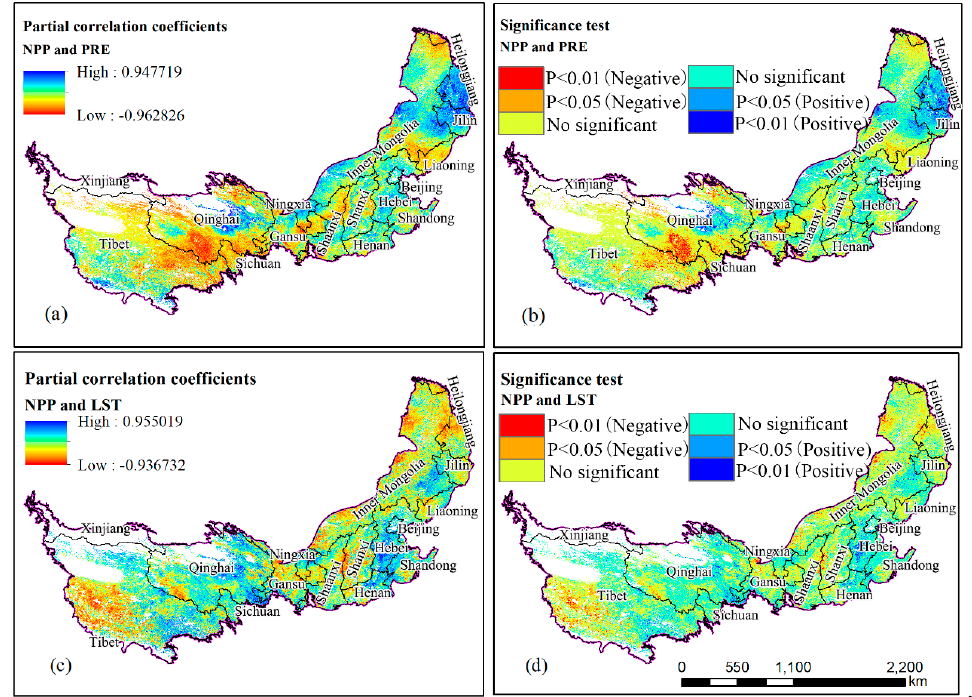
Figure 6. Spatial distribution and the T significance test of partial correlations coefficient between annual NPP and precipitation ( a, b ) and NPP and Land surface temperature ( c, d ) between 2000 and